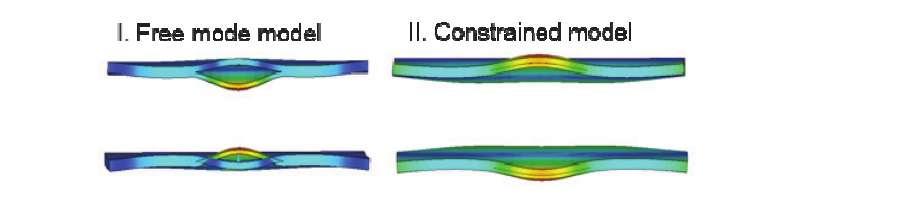
Figure 2: Models of delamination.